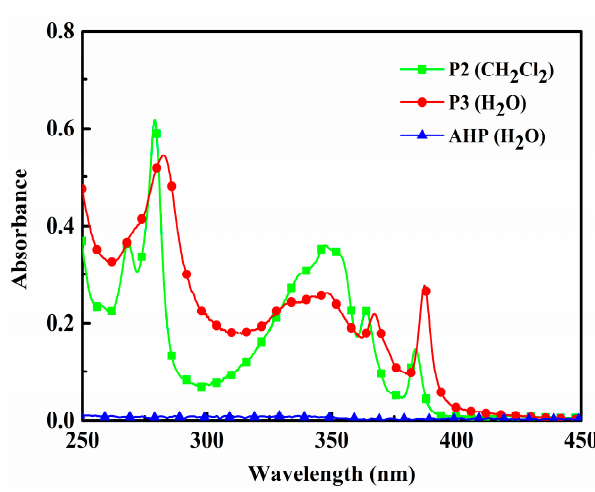
Figure 9. UV-VIS spectra of AHP, P2 , and P3 .